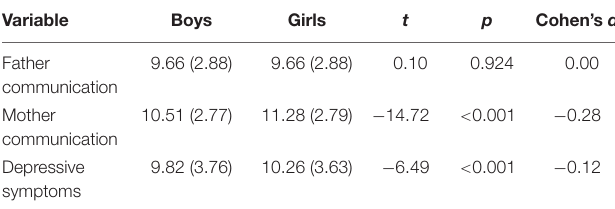
TABLE 3 | Means and standard deviations of parent-adolescent communication and depressive symptoms according gender.